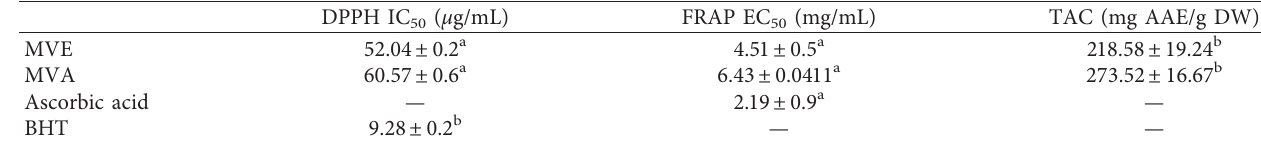
Table 2: Antioxidant activities of M. vulgare extracts by DPPH, FRAP, and TAC methods.